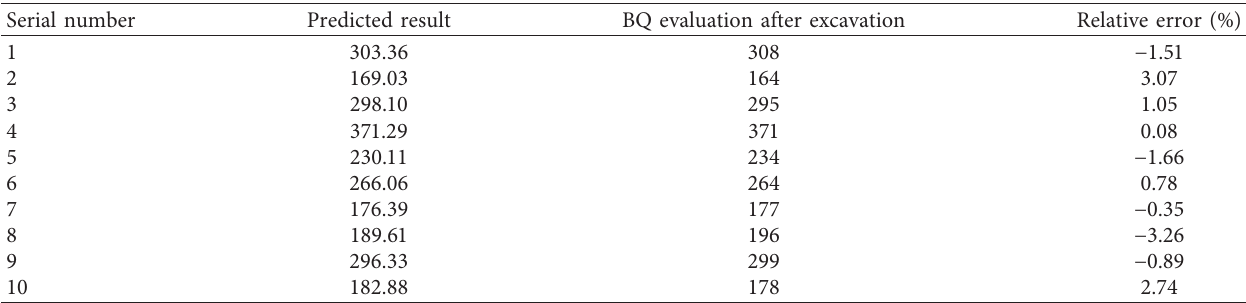
Table 5: Verification of hybrid algorithm regression effect.